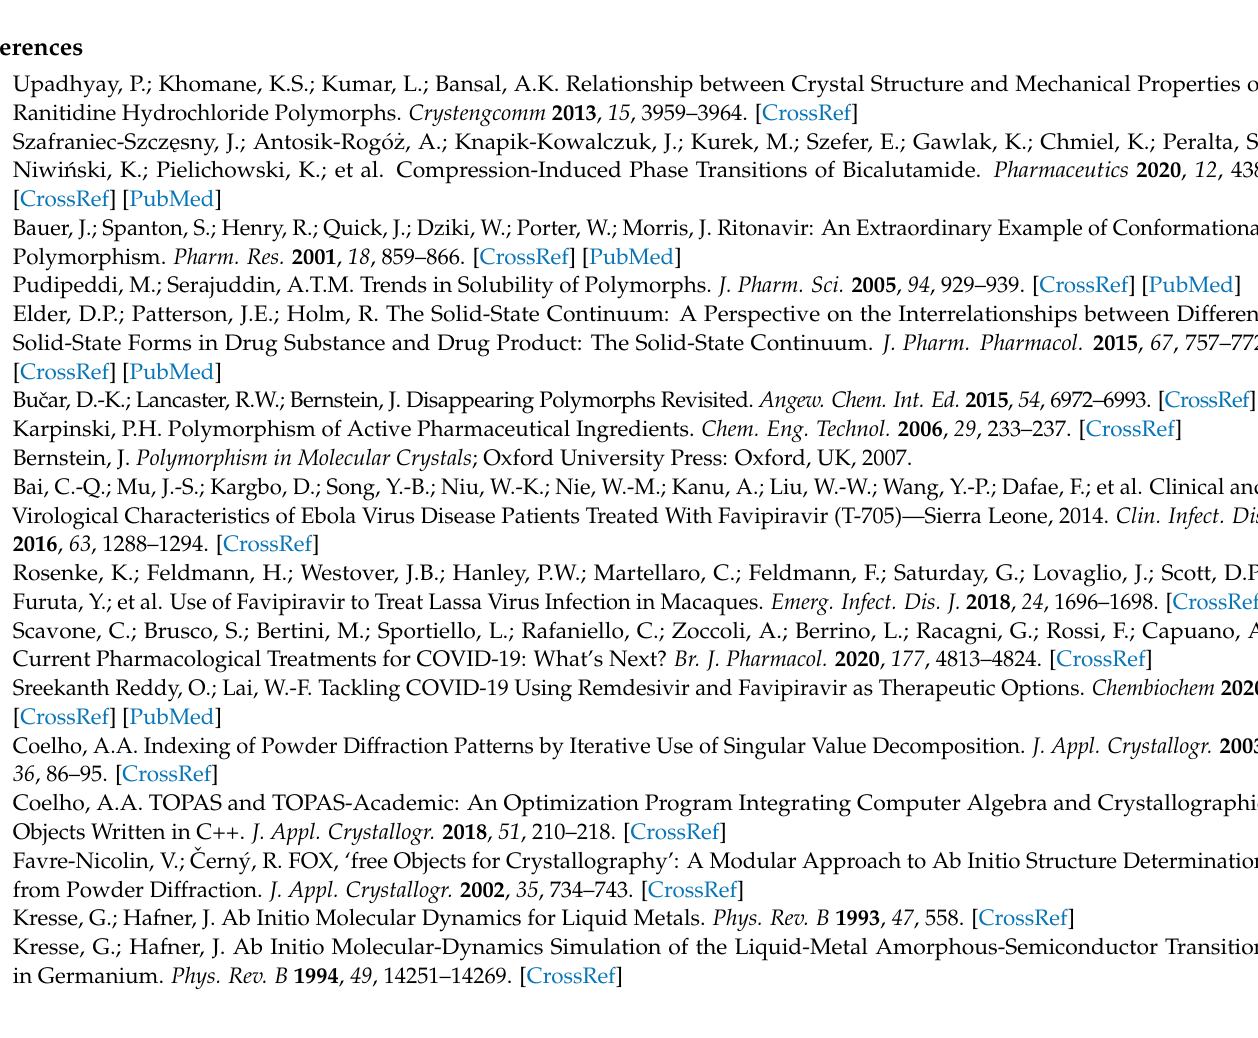
Figure S3: XRD patterns of favipiravir recrystallized from ethyl acetate after 10 months; Figure S4: topological analysis of H-bonding architectures in two polymorphs; atomic coordinates for optimized structures; Table S1. Energies (kJ mol − 1 ) of intermolecular interactions in favipiravir polymorphs calculated by the UNI force field and the dimer interaction energies calculated using Crystal Explorer based on the PIXEL method [CE-B3LYP/6-31G(d,p)]; Supplementary material S1. The results of DFT